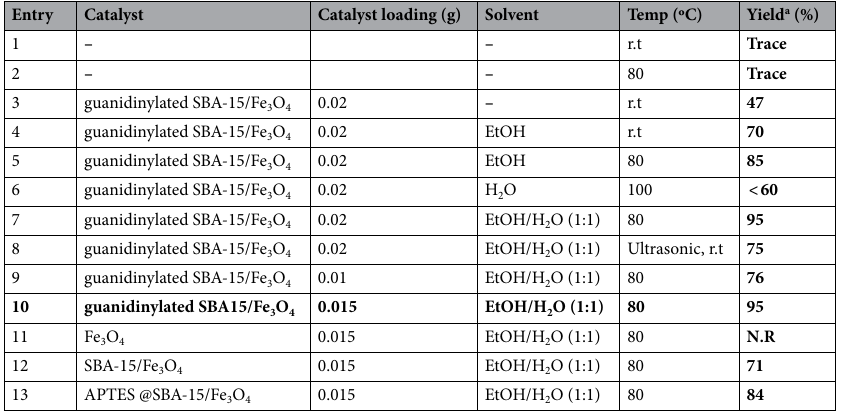
Table 2. Optimizing the reaction conditions in the synthesis of dihydropyrano[2,3-c]pyrazole derivatives. a Reaction conditions: ethyl acetoacetate (1 mmol), hydrazine hydrate (1.2 mmol),